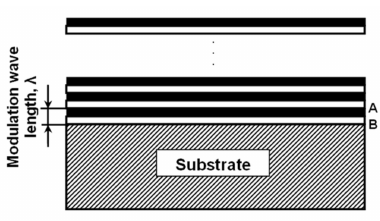
Figure 15. Schematic of the structure of superlattice film.